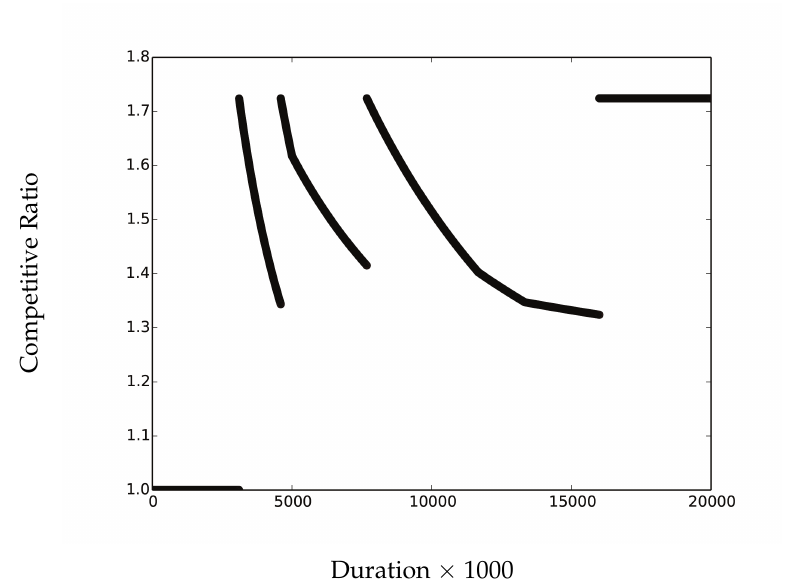
Figure 2. The solution obtained in the sample run of Table 4. Per Lemma 4 at switching times, all ratios are equal.